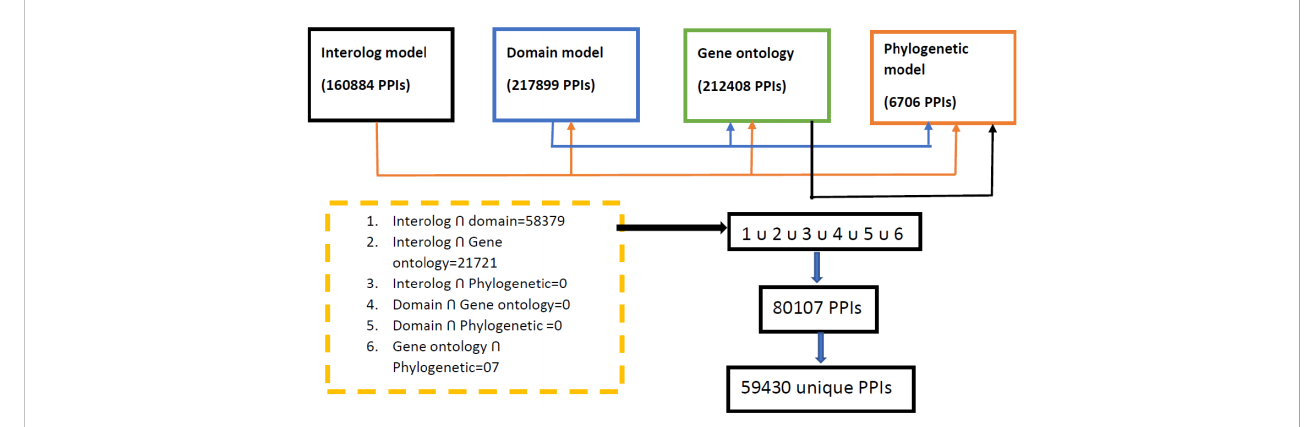
FIGURE 6 Illustration for getting the potential PPIs from the developed genomic models.